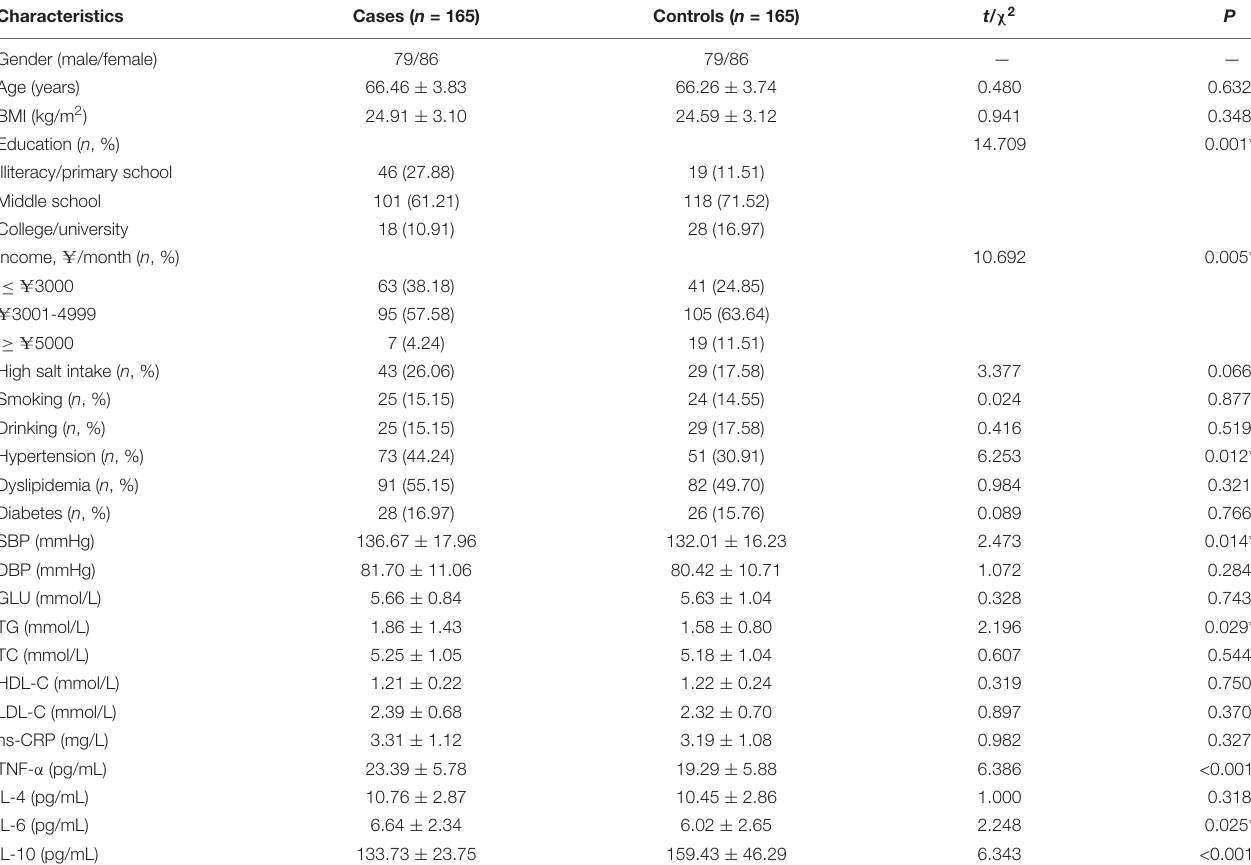
TABLE 2 | Characteristics of the study participants.